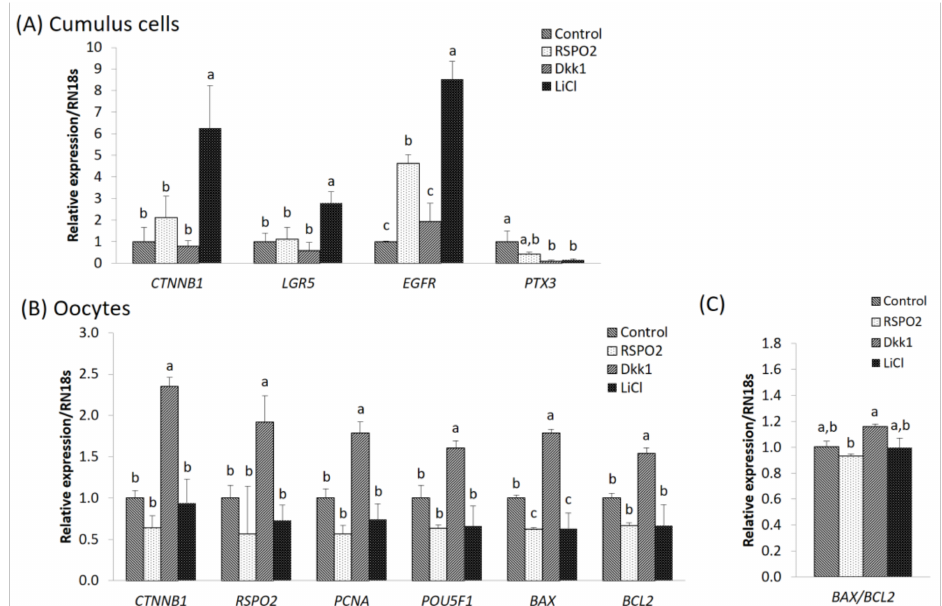
Figure 3. Expression levels of genes relative to RSPO2 and WNT signaling were determined by qPCR. Mean ± SEM expression of CTNNB1 , LGR5 , PTX3 , RSPO2 , EGFR , PCNA , POU5F1 , BAX, and BCL2 mRNA in ( A ) cumulus cells and ( B , C ) oocytes. Each gene was isolated and statistically analyzed. Within each end point, bars with different letters (a, b and c) are significantly ( p < 0.05) different. The experiment was replicated thrice. SME: standard error of the means